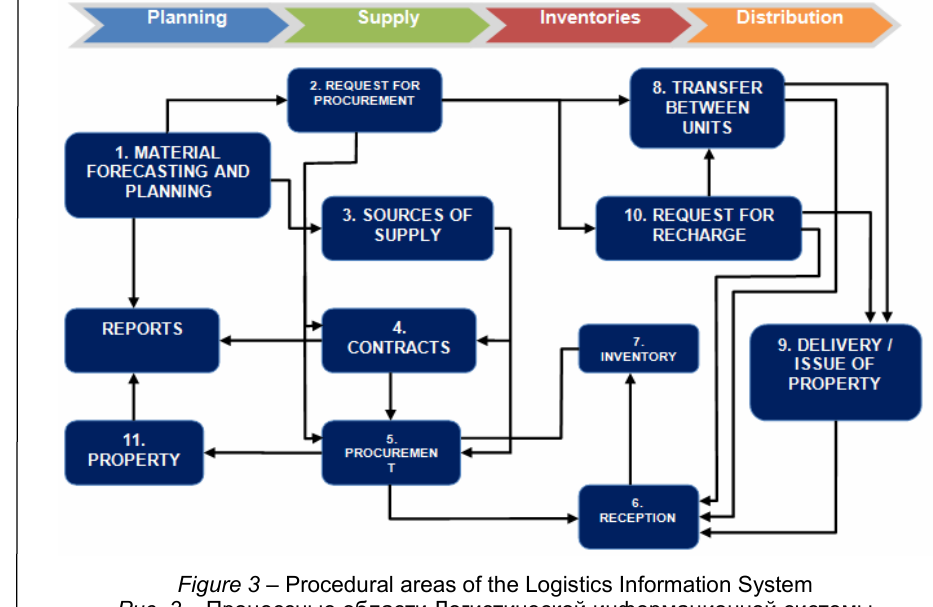
Figure 3 – Procedural areas of the Logistics Information System Рис . 3 – Процессные области Логистической информационной